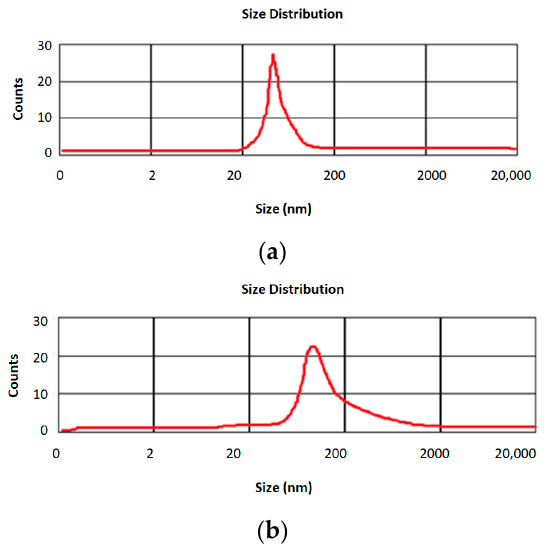
Figure 2. The average particle size for drug-free silica nanoparticles ( a ) and curcumin-loaded silica nanoparticles ( b